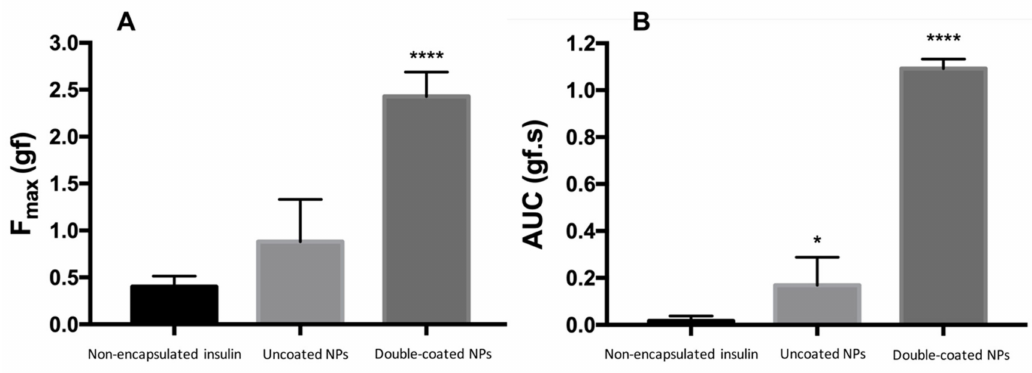
Figure 5. The peak force of displacement (F max , gf) ( A ) and the area of the peak (AUC, gf.s) ( B ) obtained from the force versus time curves. The results are presented regarding the mean value ± respective SD (* p < 0.0332; **** p <